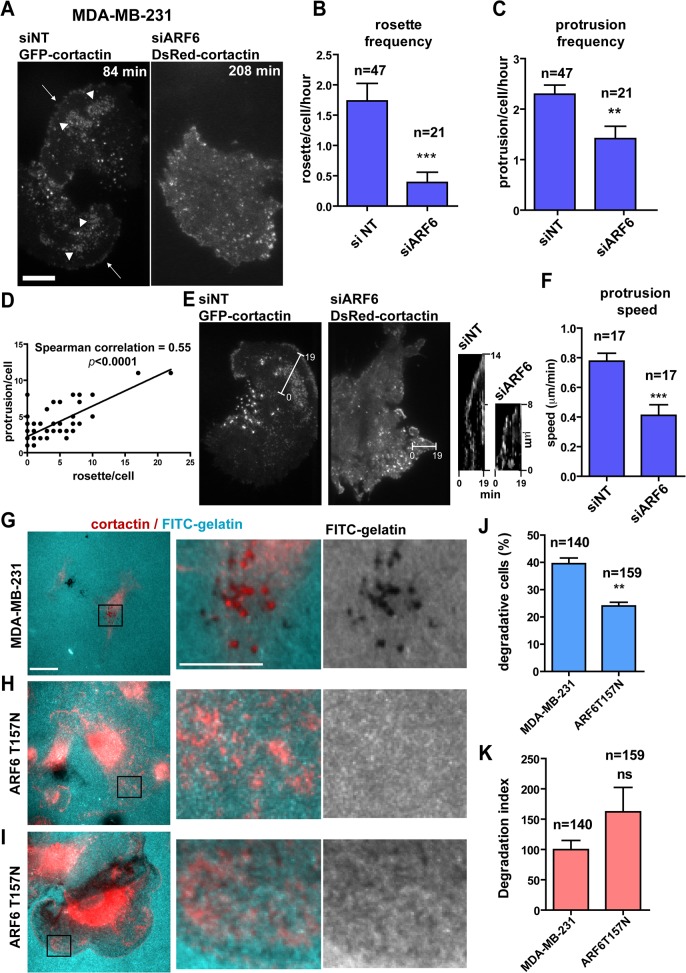
Cortactin-rich rosettes are ARF6-dependent and correlate with membrane protrusion formation.
(A) Still images of TIRFM time-lapse sequences of MDA-MB-231 cells treated with non-targeting or ARF6 siRNAs and transfected with GFP- or DsRed-cortactin, respectively. Arrowheads, ventral cortactin-positive rosettes; arrows, cortactin-enriched lamellipodia. Scale bars, 10 μm. (B-C) Frequency of cortactin-positive rosette (B) and membrane protrusion formation (C) in the indicated cell populations was calculated by scoring rosettes or protrusions occurring per cell and per hour. Values are mean ± SEM from two independent experiments. n represents the number of cells scored for each cell population. Comparisons were made with a Mann-Whitney (two-tailed) t-test. ***, P < 0.001, **, P < 0.01 (compared with siNT-treated cells). (D) Correlation between number of rosettes (x-axis) and protrusions (y-axis) scored during time-lapse sequences of control siNT-treated cells (n = 47). Correlation was calculated with a Spearman test. (E) Still images of TIRFM movies of MDA-MB-231 cells treated as in A showing extension of membrane protrusions. Kymograph views were obtained from the white lines in the still images between the first and twentieth frame with a 1 min interval between each frame. (F) Speed of membrane protrusion extension in the indicated cell populations was calculated by dividing the distance of protrusion (vertical axis in the kymographs) by the time (horizontal axis). Values are mean ± SEM from two independent experiments. n represents the number of protrusions scored for each cell population. Comparisons were made with a Mann-Whitney (two-tailed) t-test. ***, P < 0.001 (compared with siNT-treated cells). (G-I) Epifluorescence images of MDA-MB-231 cells (G) and ARF6T157N-expressing cells (H-I) stained for cortactin (red) and plated on FITC-labelled gelatin (cyan). Scale bar 10 μm. Magnification of the boxed regions of the merged images and gelatin channel are shown in the right panels. Scale bar 5 μm. (J, K) Percentage of degradative cells (J) and degradation index (K) calculated by normalizing the degradation area by the cell area in the different cell populations. Values are mean ± SD from two replicate values from one experiment. n represents the number of cells scored for each cell population. Comparisons were made with Student’s t-test. Ns, non significant, **, P < 0.01 (compared with MDA-MB-231 cells).